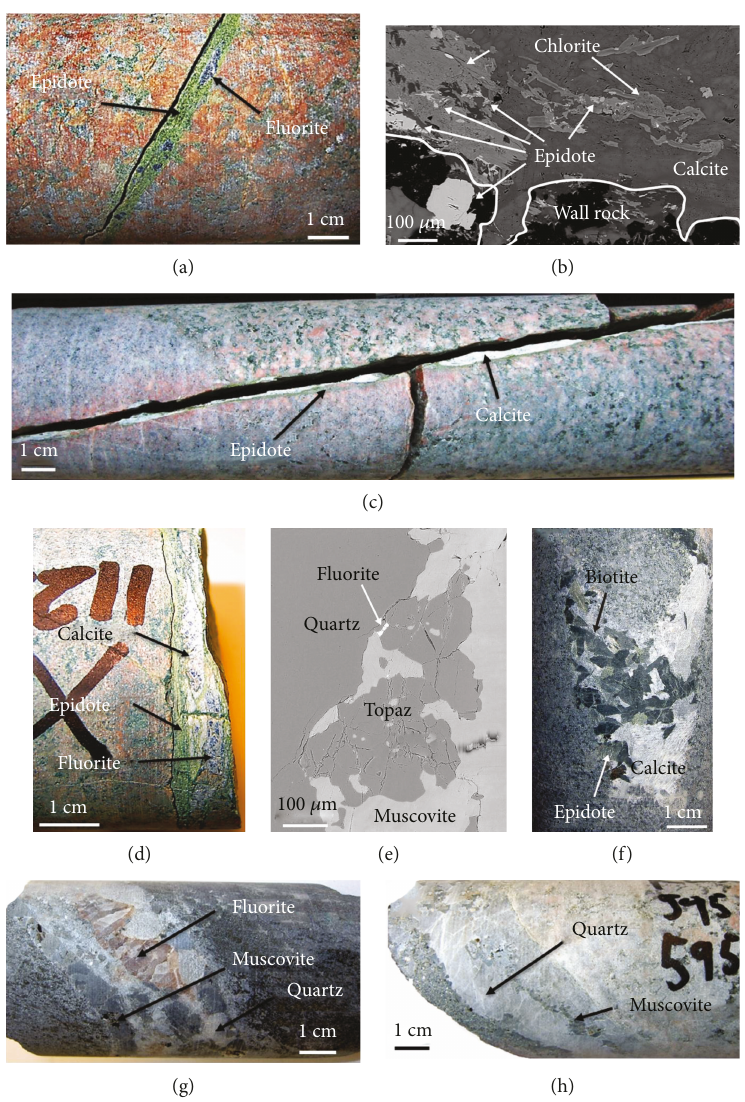
Figure 2: Representative vein (a – d) and greisen (e – h) specimens. (a) Photograph of sealed epidote- fl uorite vein; (b) BSE image of epidote and chlorite lining a vein with calcite in the centre and in a veinlet penetrating into the wall rock; (c) photograph of a reactivated (presently open) vein with epidote closest to the wall rock and calcite precipitated after epidote; (d) photograph of a sealed epidote-calcite- fl uorite vein; (e) BSE image of topaz intergrown with muscovite, fl uorite, and quartz in greisen; (f) photograph of greisen containing epidote, biotite, and calcite; (g) photograph of fl uorite-rich greisen with muscovite and quartz; (h) photograph of fl uorite-poor greisen composed of quartz, muscovite, and low amounts of fl